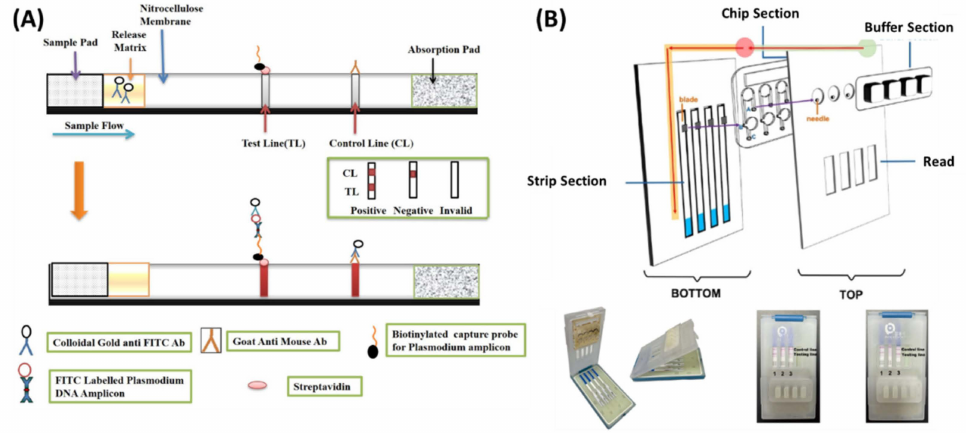
Figure 4. LAMP-based lateral flow biosensors. ( A ) Outline of the lateral flow strip for detection of LAMP amplicons. ( B ) A portable microfluidic platform integrated with a pregnancy test strip (PTSs) for POC diagnosis of COVID-19. Reproduced with permission from references [90,92]. Copyright 2021 American Chemical Society, 2022